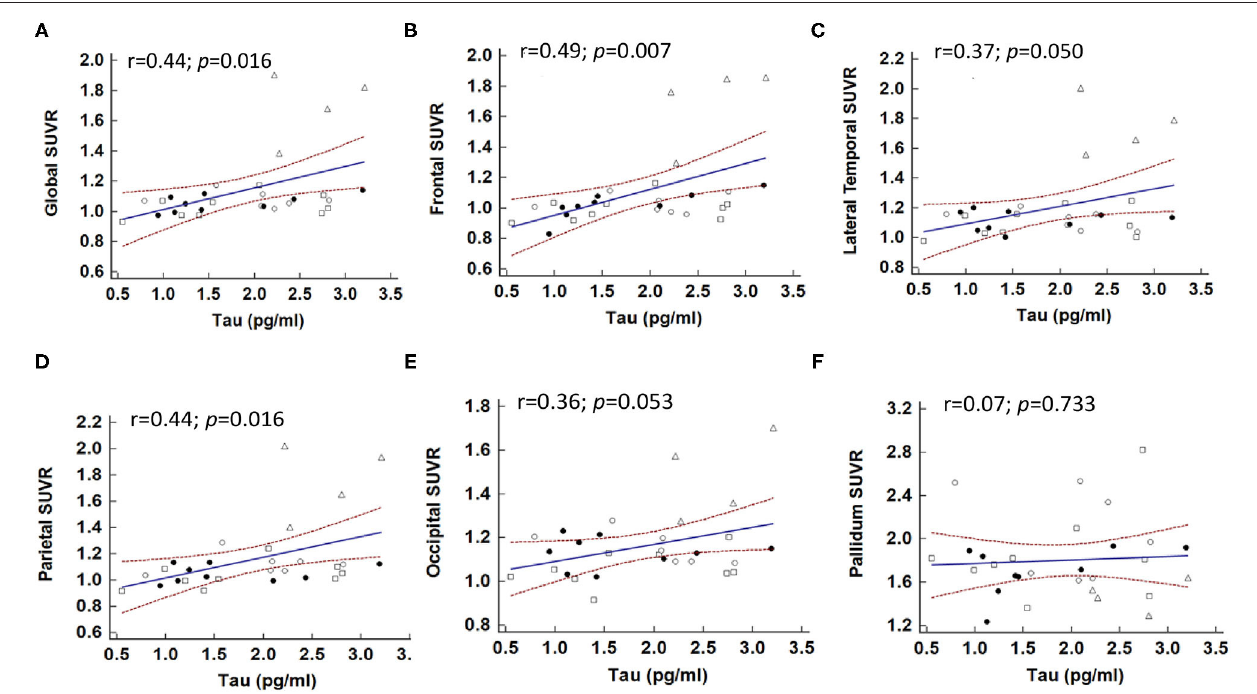
FIGURE 3 | Correlations between plasma total tau level and brain regional SUVR in patients with tauopathies. The correlations between global (A) and individual brain regions, including (B) frontal, (C) lateral temporal, (D) parietal, (E) occipital, and (F) pallidum and plasma total tau level. Solid dot: CBS; open dot: PSP; square: FTD; triangle: AD.